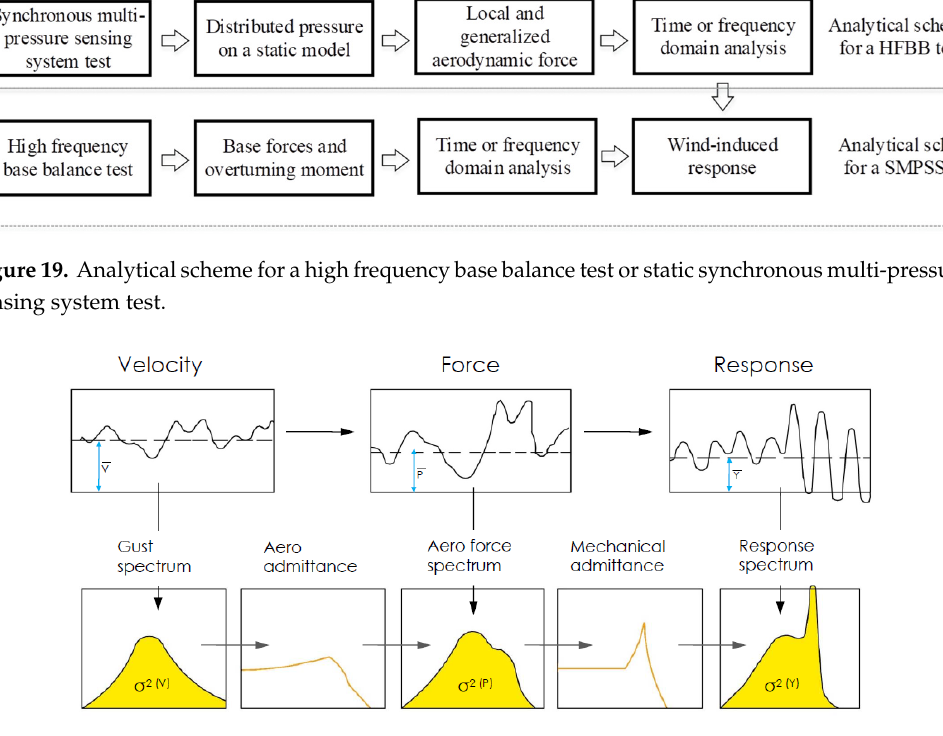
Figure 20. Elements of the statistical approach to gust loading [82].